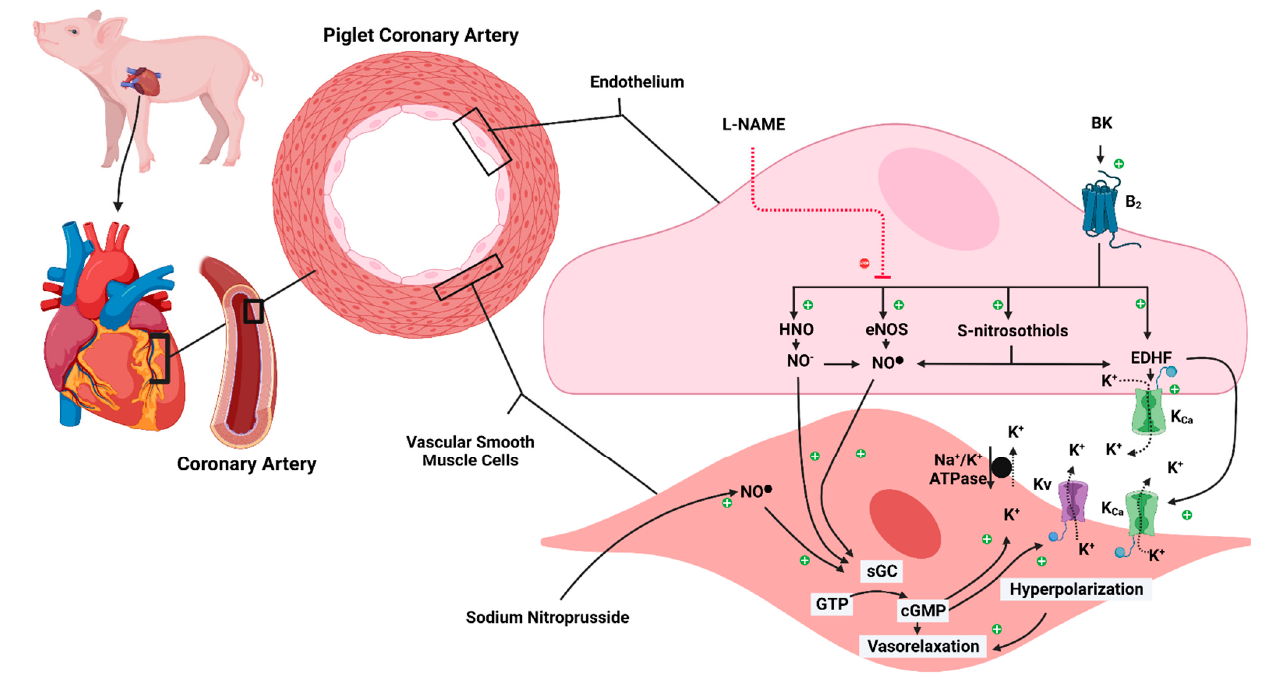
Figure 7. Schematic representation of ECMO-induced endothelial dysfunction. B 2 : bradykinin receptors 2; BK: bradykinin; cGMP: 3 ′ -5 ′ -cyclic guanosine monophosphate; ECMO: extracorporeal membrane oxygenation; ECMO: extracorporeal membrane oxygenation; EDHF: endothelium-derived hyperpolarization factor; eNOS: endothelial nitric oxide synthase; GTP: Guanosine-5 ′ -triphosphate; HNO: nitroxyl; K + : potassium ion; K Ca : calcium-activated potassium channel; K v : voltage-gated potassium channel; L-NAME: N ω -nitro-L-arginine methyl ester HCl; Na + /K + ATPase: sodium-potassium adenosine triphosphatase; NO - : nitroxyl anion; NO ● : neutral free radical nitric oxide; sGC: soluble guanylate cyclase. The dashed red line has an inhibiting action. The solid black arrow has an activation action. The dashed black arrow indicates the getaway of the K ion from the cell. Created with BioRender.com.